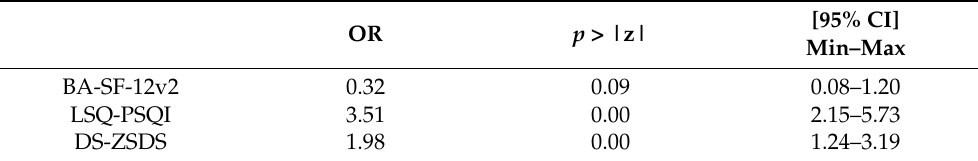
Table 3. Association between people with CD and outcome variables (BA -SF-12v2; LSQ-PSQI and DS-ZSDS).